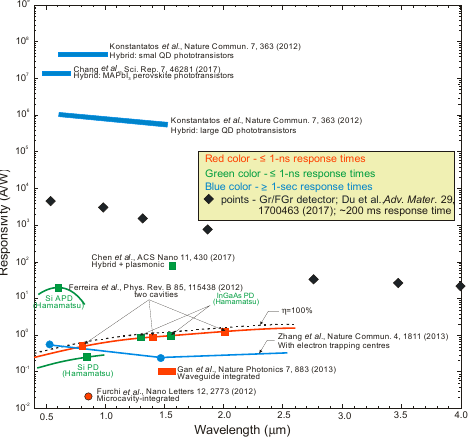
Figure 1. Spectral responsivity of graphene photodetectors compared with commercial